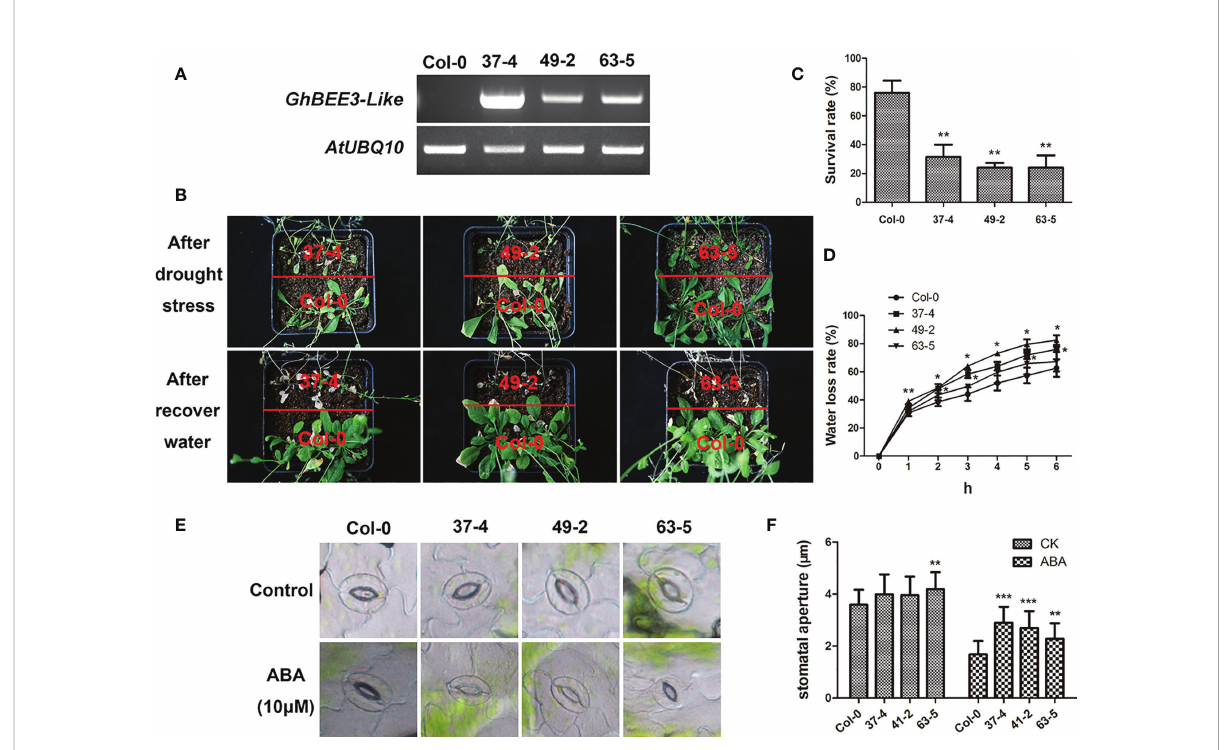
FIGURE 6 Phenotypic characterization of transgenic GhBEE3-Like Arabidopsis under drought conditions. (A) Overexpression of GhBEE3-Like in Arabidopsis was determined by RT-PCR. AtUBQ10 was employed as an internal reference. (B) The phenotypes of Col-0 Arabidopsis and GhBEE3-Like transgenic lines after drought treatment and water recovery. GhBEE3-Like transgenic lines were more vulnerable to drought stress than control plant, Col-0. (C) Survival rates of Col-0 Arabidopsis and GhBEE3-Like transgenic lines after recovery from water loss for 7 days. Three biological replicates were used. Mean ± SD (n = 18, Student ’ s t -test, ** P < 0.01). (D) Water loss rates of one-month-old leaves of Col-0 Arabidopsis and GhBEE3-Like transgenic lines. Three biological replicates were employed for detection. Mean ± SD (n = 3, Student ’ s t -test * P < 0.05, ** P < 0.01). (E) Stomata aperture observations of Col-0 Arabidopsis and GhBEE3-Like transgenic lines under normal conditions and after ABA treatment. (F) Statistical analysis of stomata aperture of Col-0 Arabidopsis and GhBEE3-Like transgenic lines shown in (E) Mean ± SD (n = 27, Student ’ s t -test, ** P < 0.01, *** P <